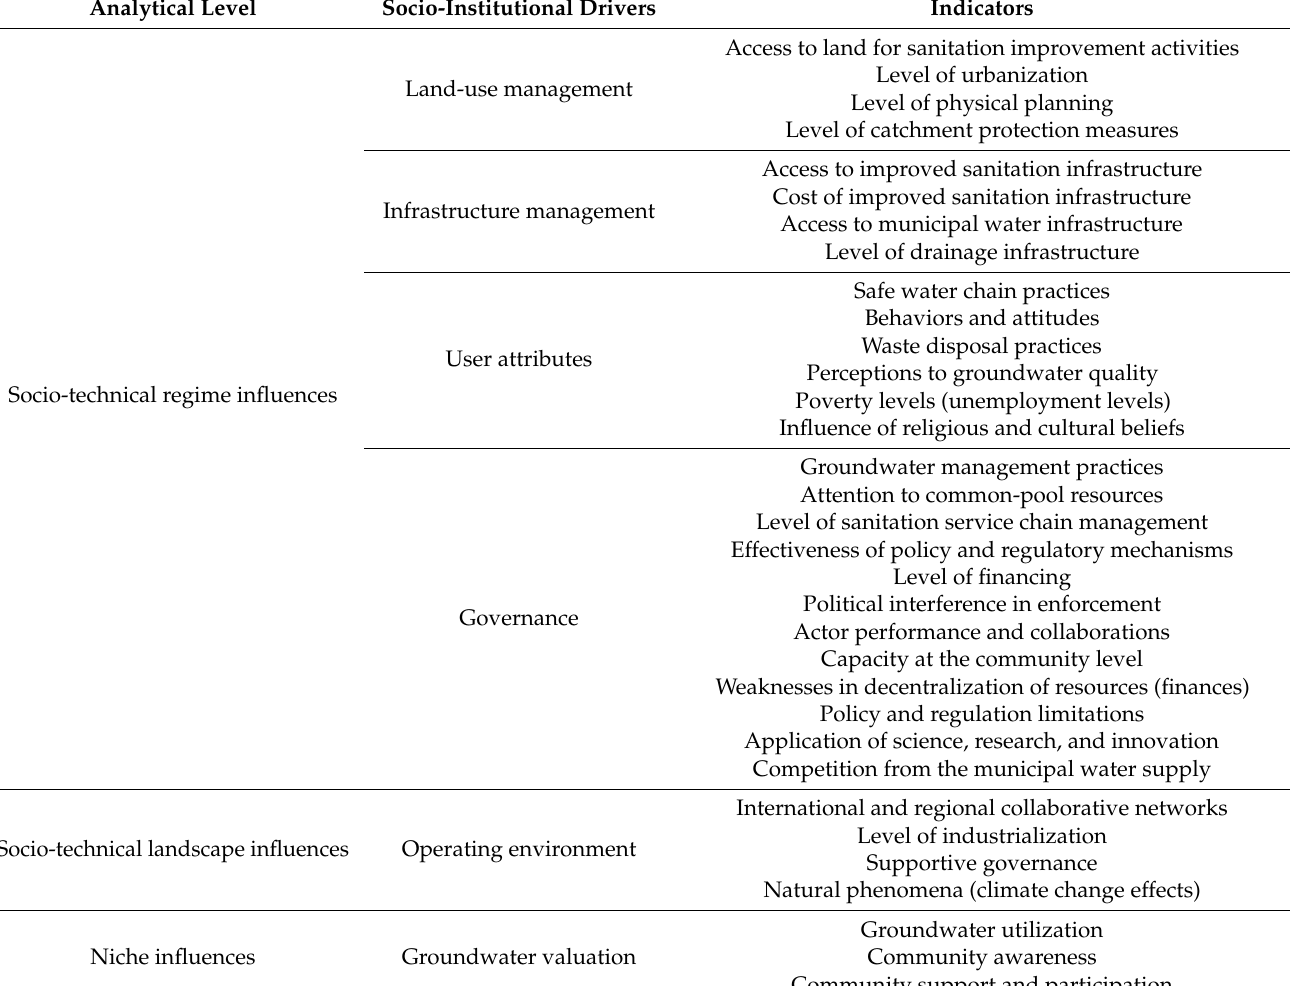
Table 3. Socio-institutional drivers and indicators of groundwater contamination by on-site sanitation in the Bwaise informal